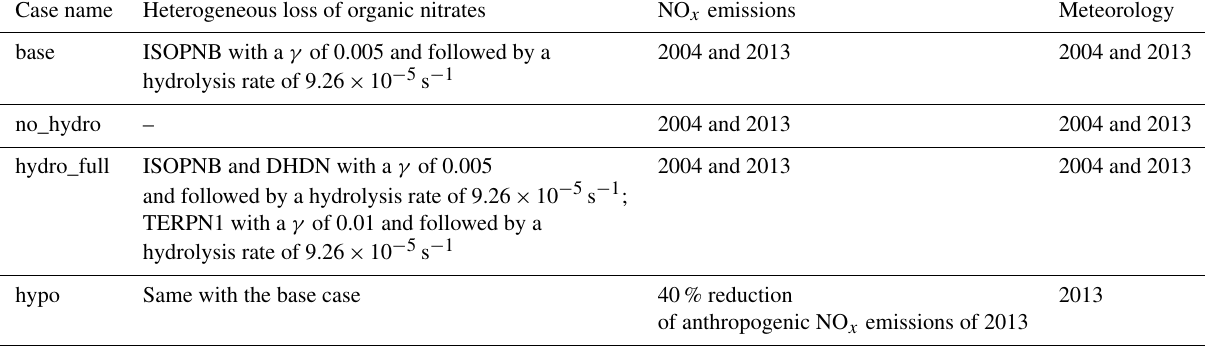
Table 2. Case descriptions.